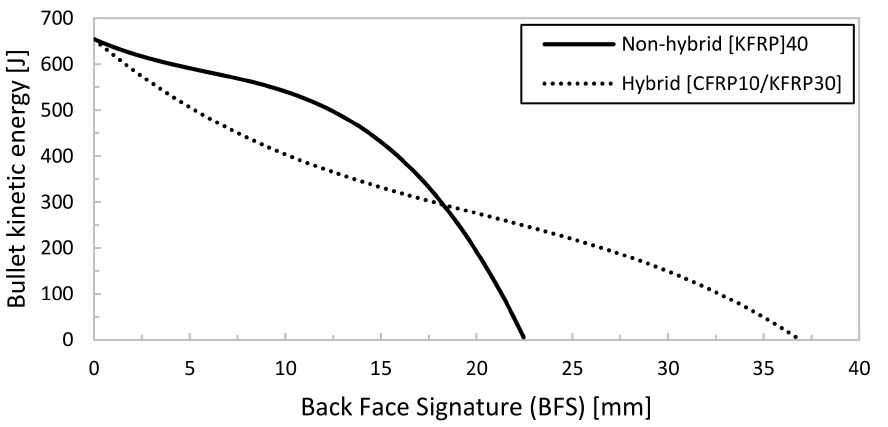
Figure 6. Bullet’s kinetic energy–BFS for non-hybrid [KFRP 40 ] and hybrid [CFRP 10 /KFRP 30 ]